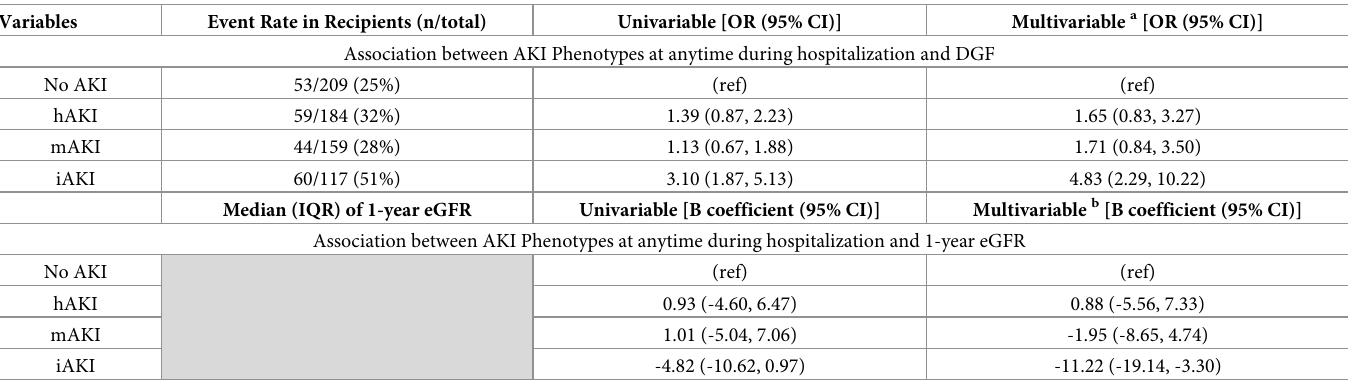
Table 5. Associations between AKI phenotypes and DGF and 1-year eGFR.